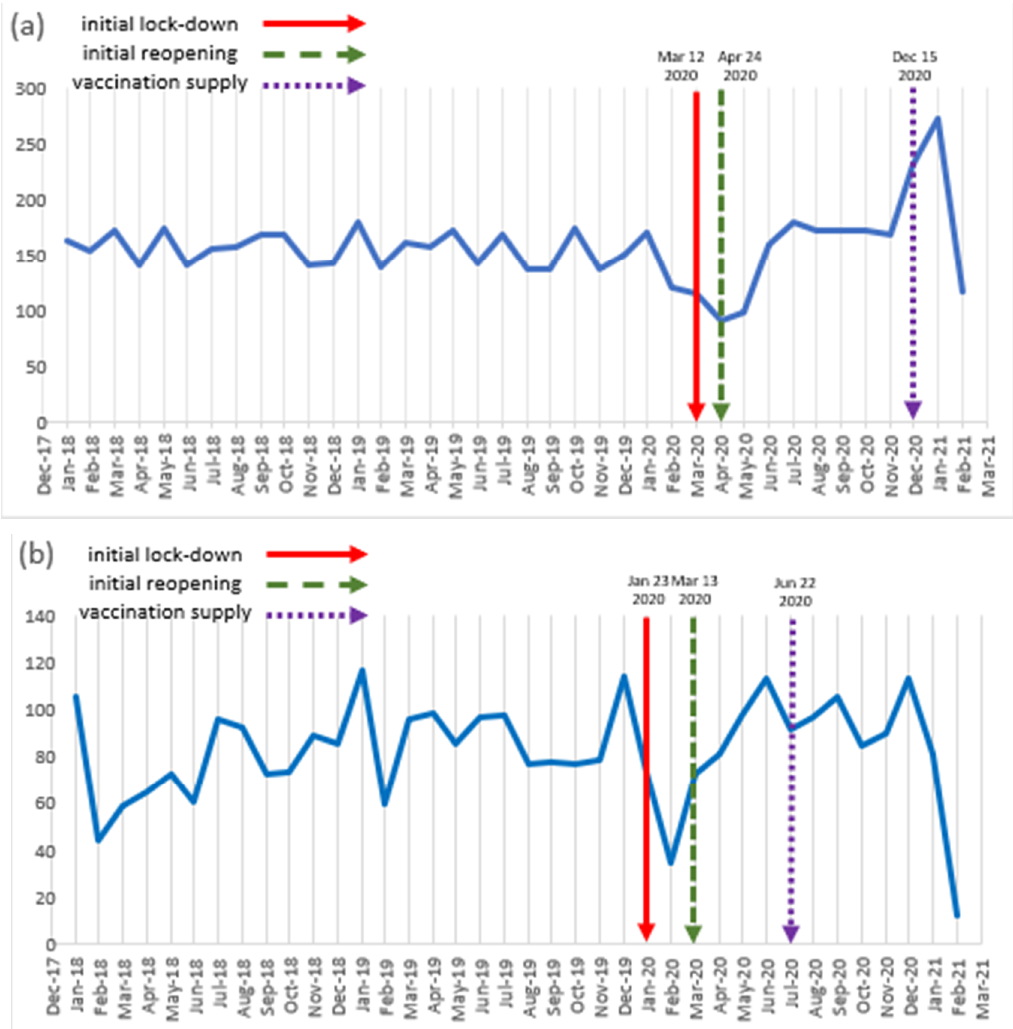
Figure 2. Monthly trends in the commencement of new oncology trials from 1 January 2018 to 28 February 2021.